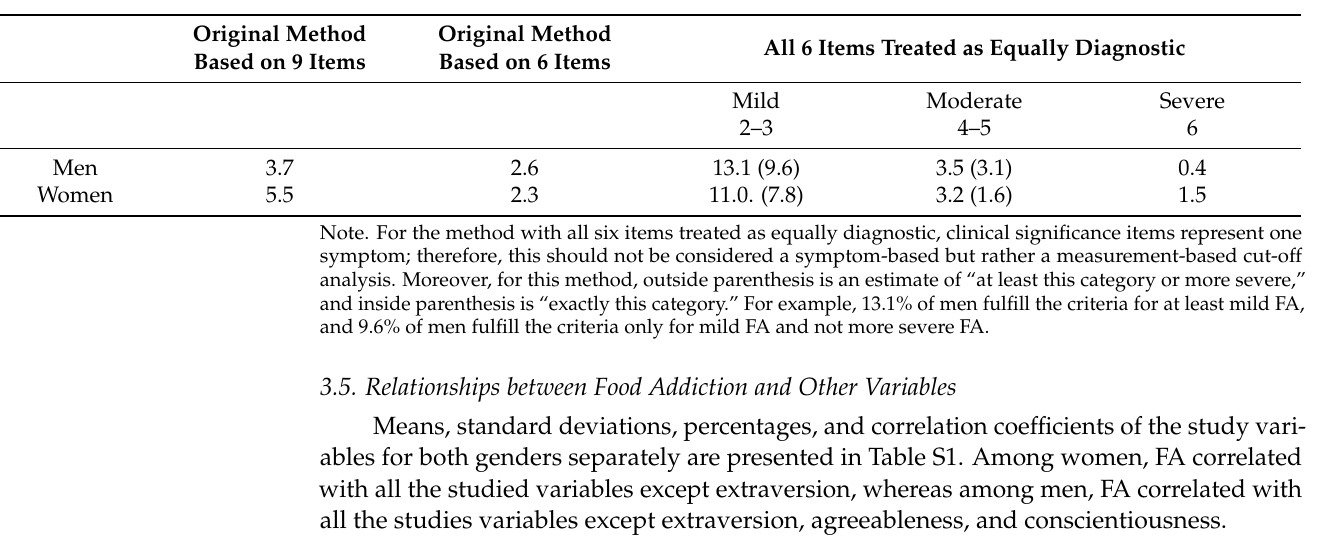
Table 4. Prevalence (percentage of the participants fulfilling diagnostic criteria) of food addiction among men and women based on different approaches to establishing cut-off